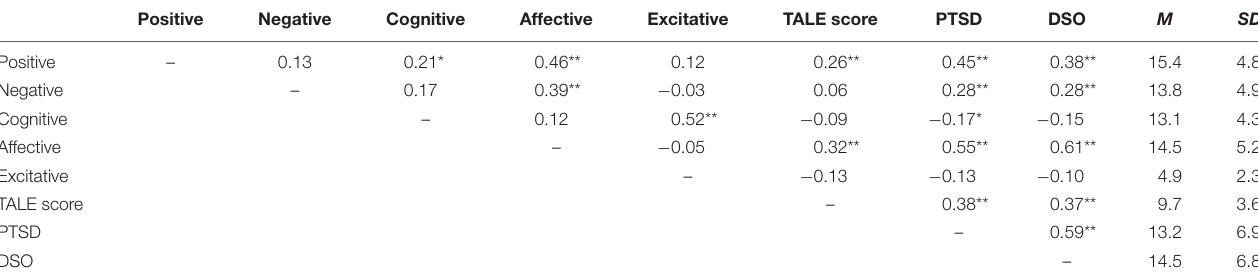
TABLE 1 | Bivariate Pearson correlations between PANSS subscales and trauma